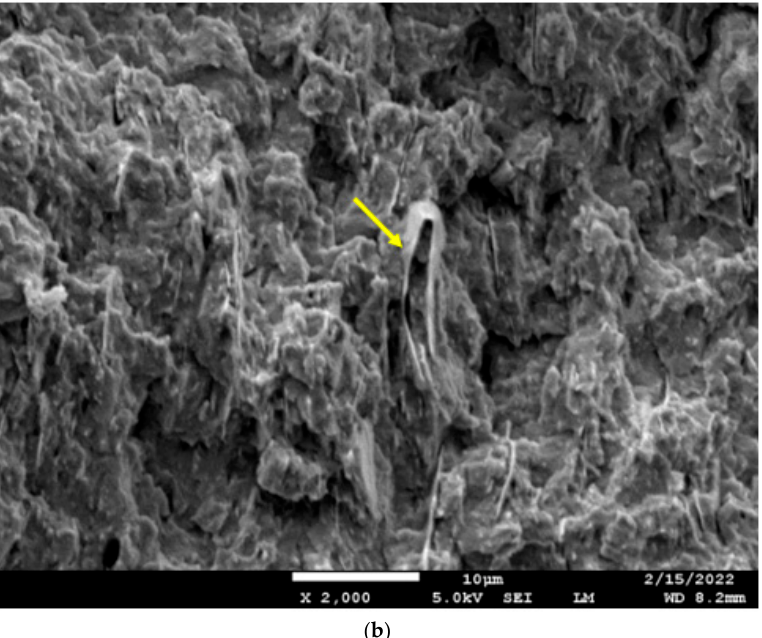
Figure 15. ( a ) SEM image of the cryo-fracture surface of a bar of the 60/40 PBT/PET blend with 10 vol.% Al flakes. The platelets are seen edgewise. The rectangle in the left corner is the cross-section of the bar (not to scale) and is placed to visualise the platelet orientation relative to the bar. The arrow shows polymer coating on a platelet. Dotted arrow shows a folded platelet. The white size bar = 10 μ m. ( b ) SEM image of the cryo-fracture surface of a bar of the 60/40 PBT/PET blend with 25 vol.% of Al nano platelets. The platelets are seen edgewise. The arrow shows a folded platelet with polymer coating. The white size bar = 10 μ m.